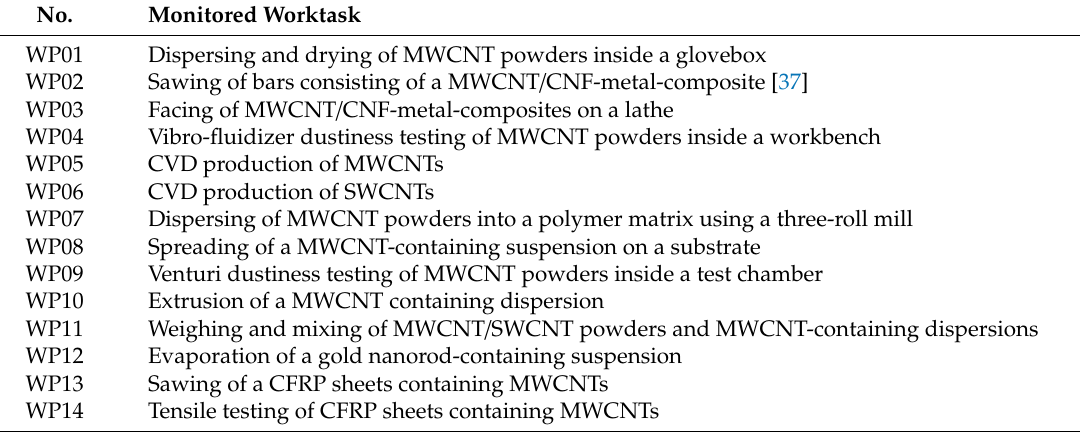
Table 13. The proposed measurement strategy was studied at the following 14